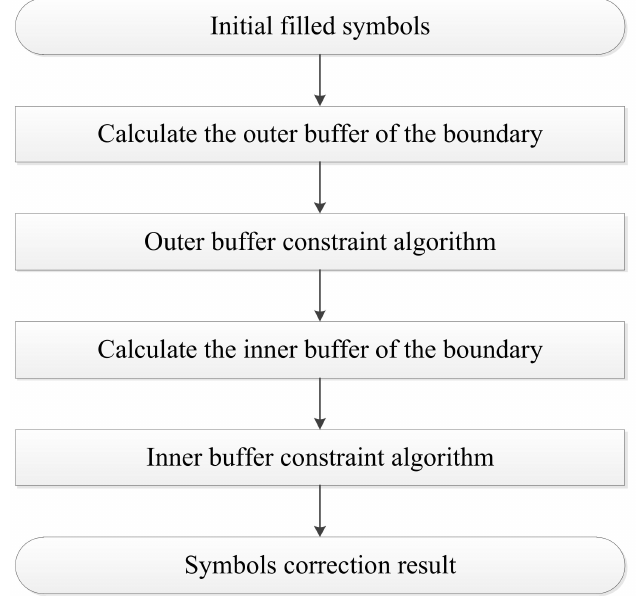
Figure 5. The flow chart of symbol correction under boundary